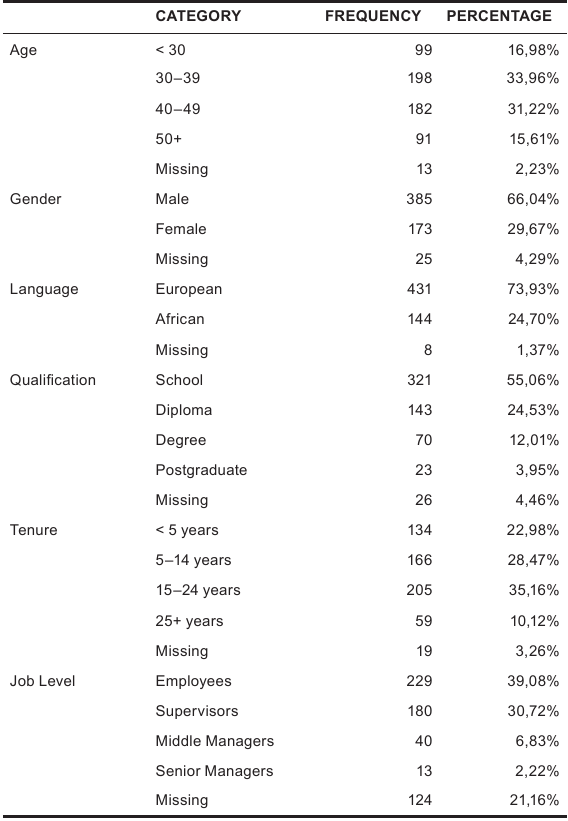
table 1 Participant characteristics (n = 583